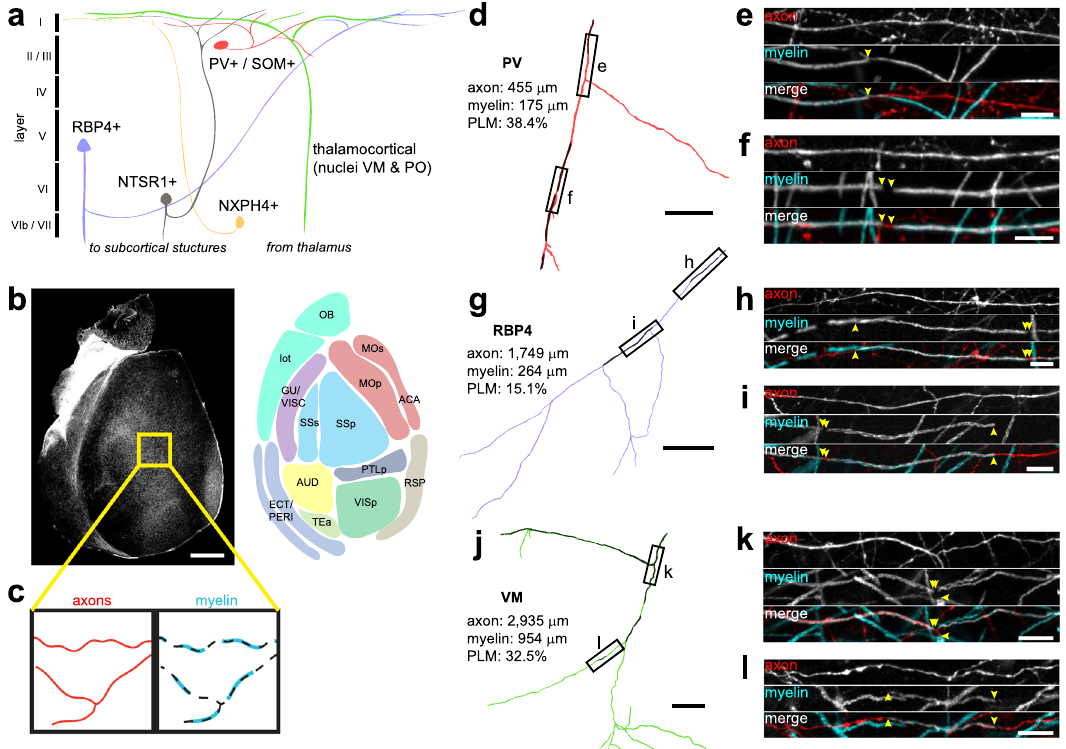
Fig. 1 High-resolution tracing of distinct axon populations reveals discontinuous myelination patterns. a Schematic of the cortex indicating the sources of axons from the distinct neuronal populations investigated. Note that the axons depicted may not necessarily be the primary projection of each neuron. b A horizontal section of the entire cortical fl atmount and schematic representing approximate cortical areas. N = 4 mice per neuron subtype. c Schematic of experimental design. Traces (black dotted line) of fl uorescently labeled axons (red) were used to trace corresponding MBP-immunostained myelin sheaths (cyan). d – I Full reconstructions of traced PV ( d ), RBP4 ( g ), and VM ( j ) axons within cortical layer I and their associated dimensions (PLM, percent length myelinated). Black myelin sheaths are overlaid on colored axons. Labeled rectangles highlight example myelinated segments of PV ( e , f ), RBP4 ( h , i ), and VM ( k , l ) axons. Yellow arrowheads indicate the ends of myelin segments (MBP immunoreactivity). n = 60 (PV), 62 (VM), 60 (SOM), 61 (PO), 60 (NXPH4), 78 (RBP4), 60 (NTSR1) axons. Scale bars, b , 1 mm; d , g , j : 100 μ m; e , f , h , i , k , l : 10 μ m. OB olfactory bulb, lot lateral olfactory tract, MOp/MOs primary/secondary motor, ACA anterior cingulate area, GU/VISC gustatory/visceral, SSp/SSs primary/secondary somatosensory, PTLp posterior parietal association, AUD auditory, RSP retrosplenial, VISp primary visual, ECT/PERI ectorhinal/perirhinal, TEa temporal association.